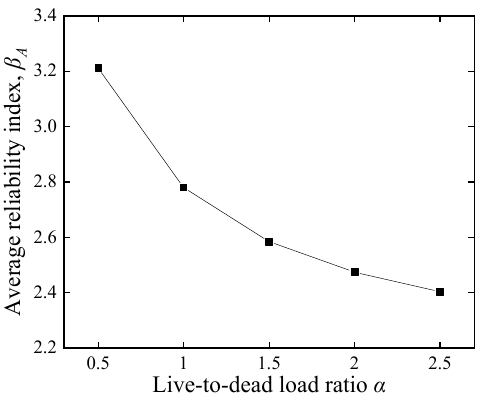
Figure 16. Effect of the live-to-dead load ratio on the average reliability index.